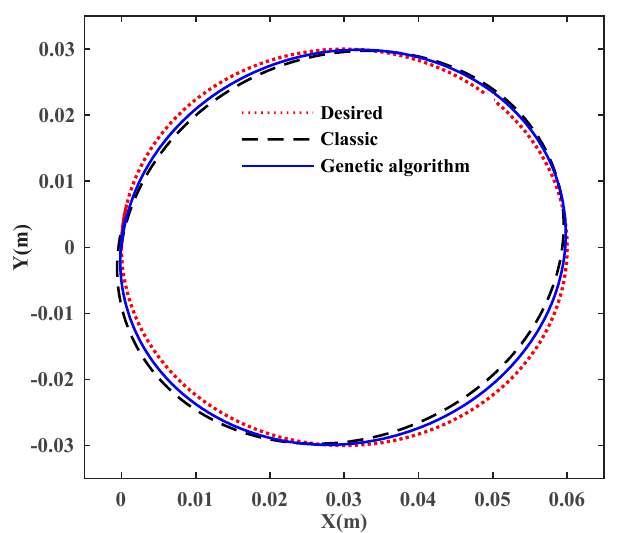
Figure 11. Trajectory of the end-effector using the classic PID and the PID optimized by a genetic algorithm in the presence of disturbances.